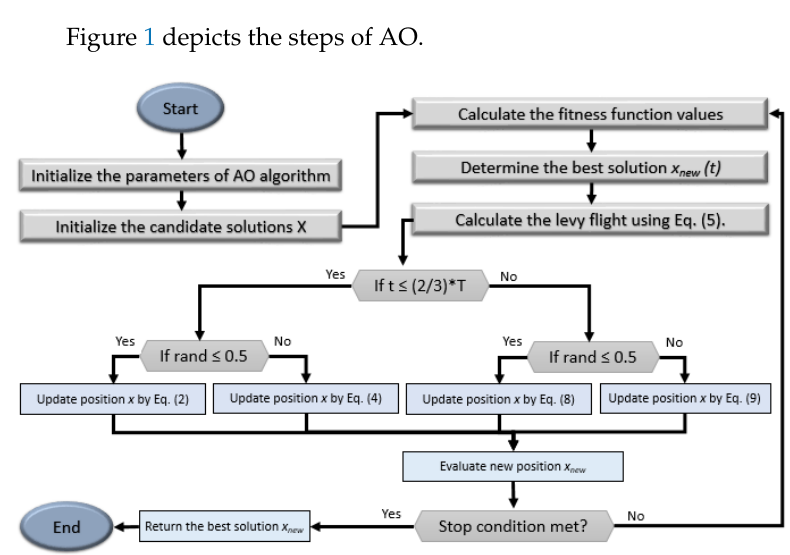
Figure 1. Flowchart for